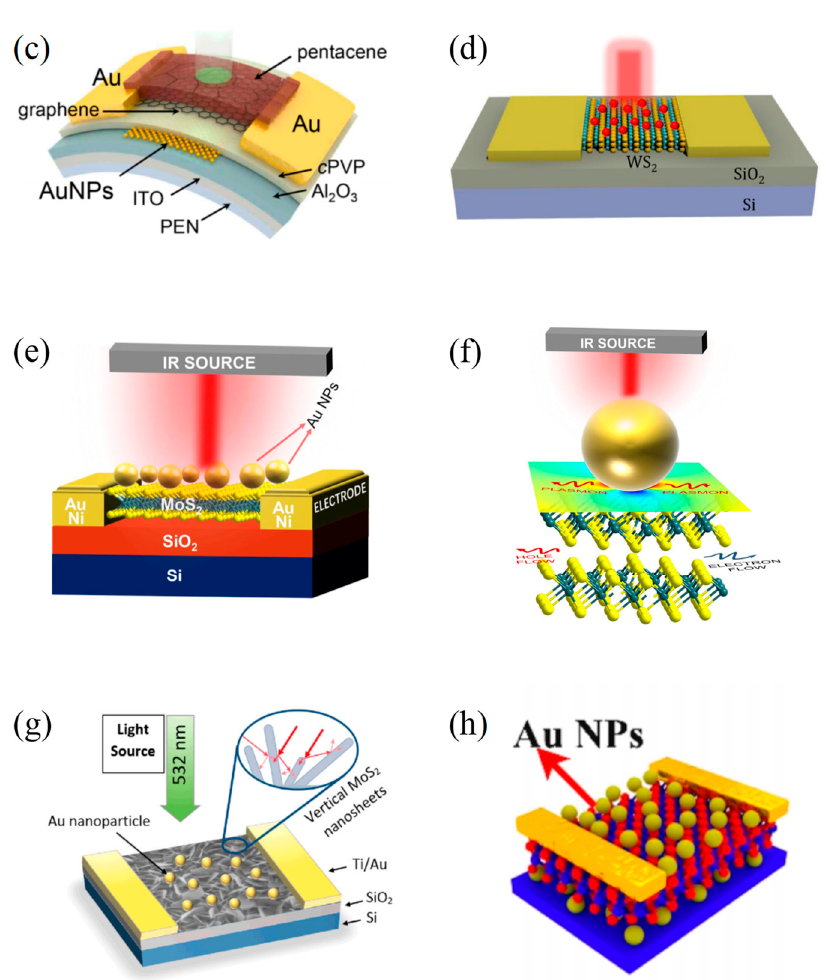
Figure 8. Structures of 2D materials-based infrared PDs with nanoparticles. ( a ) Schematic of the surface plasmon enhanced high-performance NIR PD. Copyright 2014, Scienti fi c Reports [63]. ( b